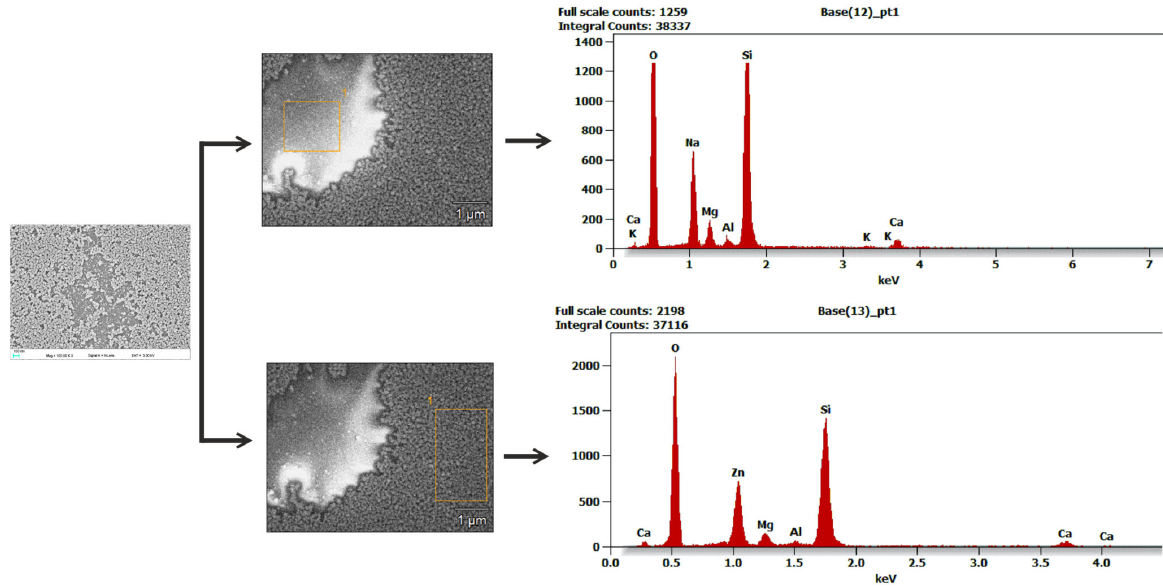
Figure 9. EDS analysis of a thin film of ZnO ‐ 2.